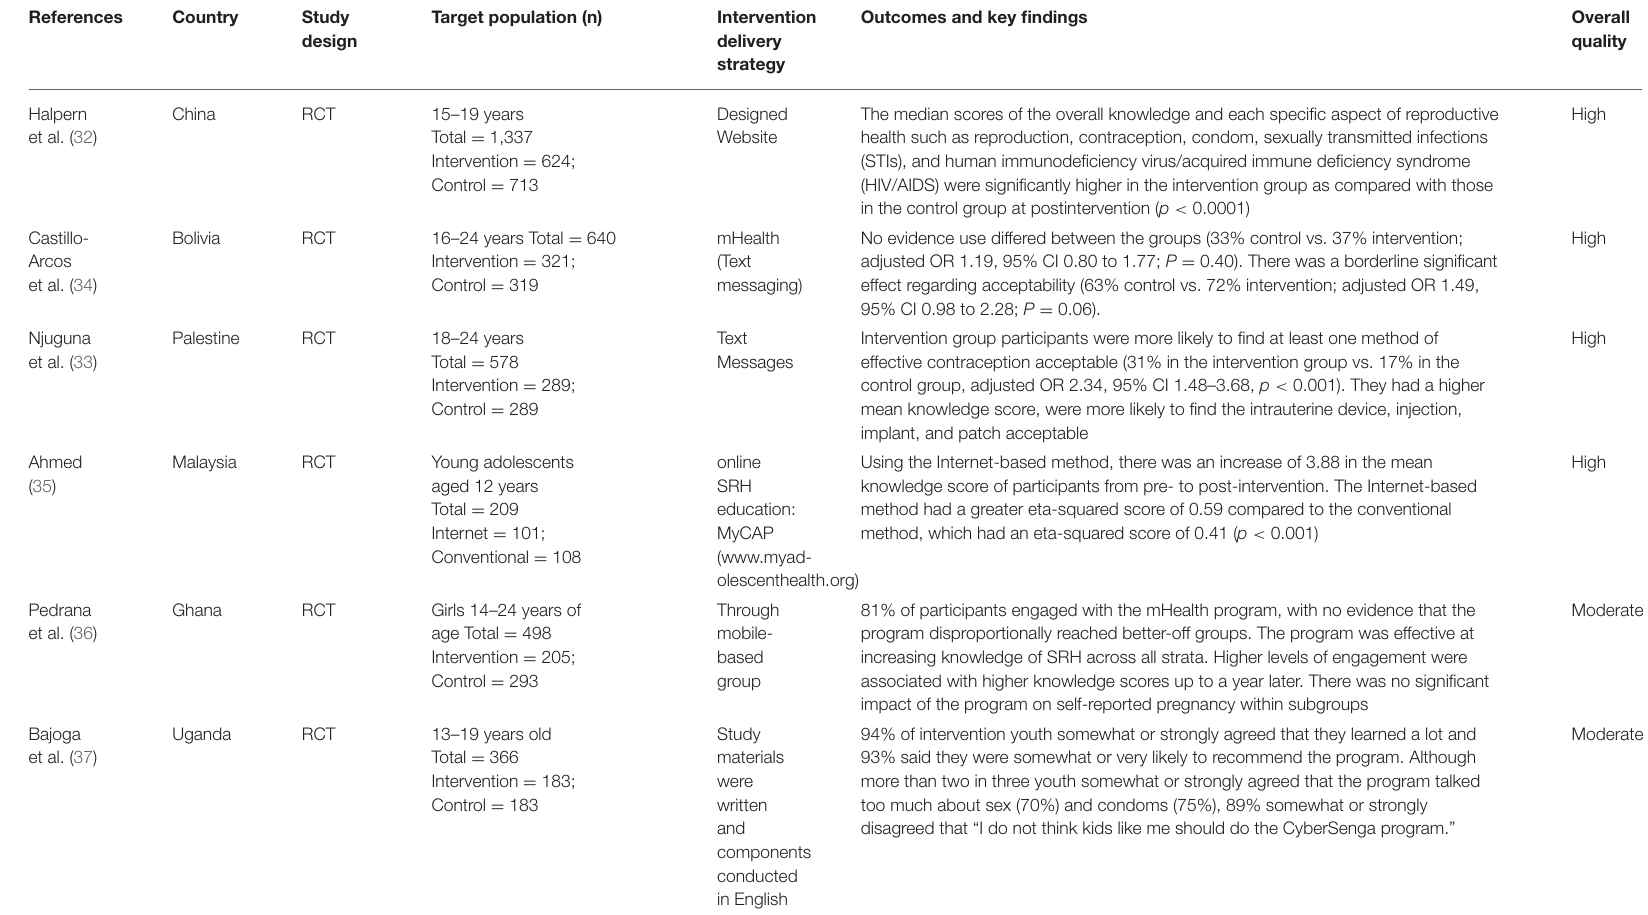
TABLE 1 | Study characteristics of interventional